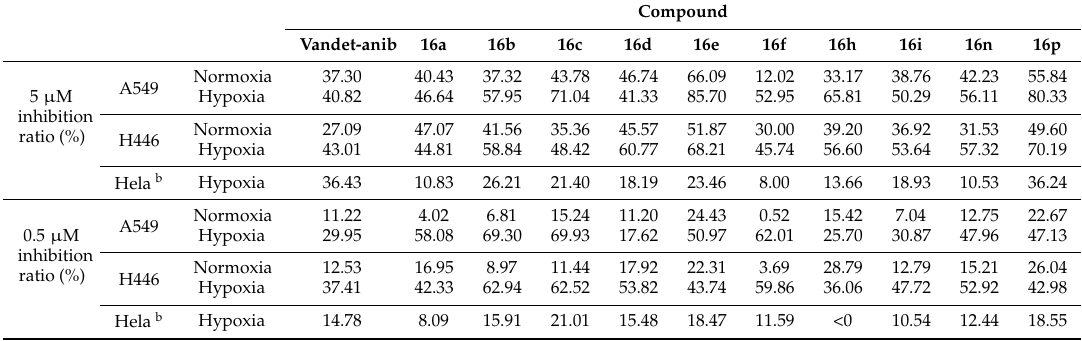
Table 2. In vitro anti-proliferative activity assay results of target compounds in normoxia and hypoxia a .